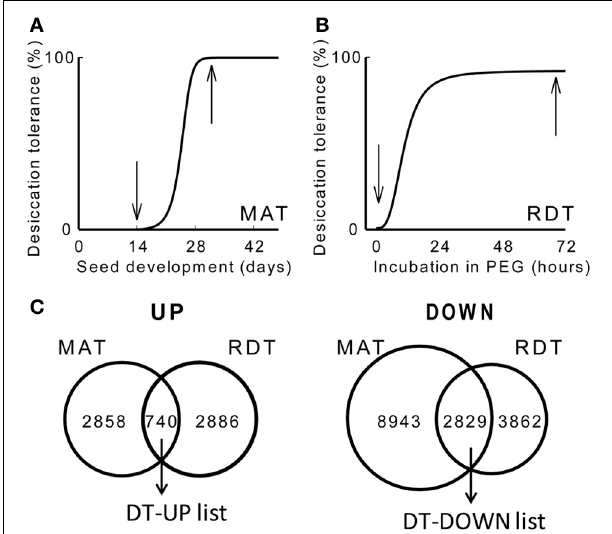
FIGURE 1 | Changes in desiccation tolerance (DT) and the associated desiccome in Medicago truncatula . ( A,B ) Schematic representation of the acquisition of DT during seed maturation (MAT) at the indicated days after pollination (DAP) [ A , curve taken from Chatelain et al. (2012)] and the re-establishment of DT (RDT) in emerged radicles of germinated seeds during the incubation in a polyethylene glycol solution (PEG) at − 1.7MPa [ B , curve taken from Buitink et al. (2006)]. Arrows indicate the time at which samples were taken for the transcriptome analysis. (C) Venn diagrams comparing the overlapping transcripts whose levels are increased (UP) or decreased (DOWN) during the transition from a desiccation-sensitive to -tolerant stage during maturation (MAT) and PEG incubation (RDT). Genes were considered statistically different when − 1 < M(log2) > 1 and P < 0 .